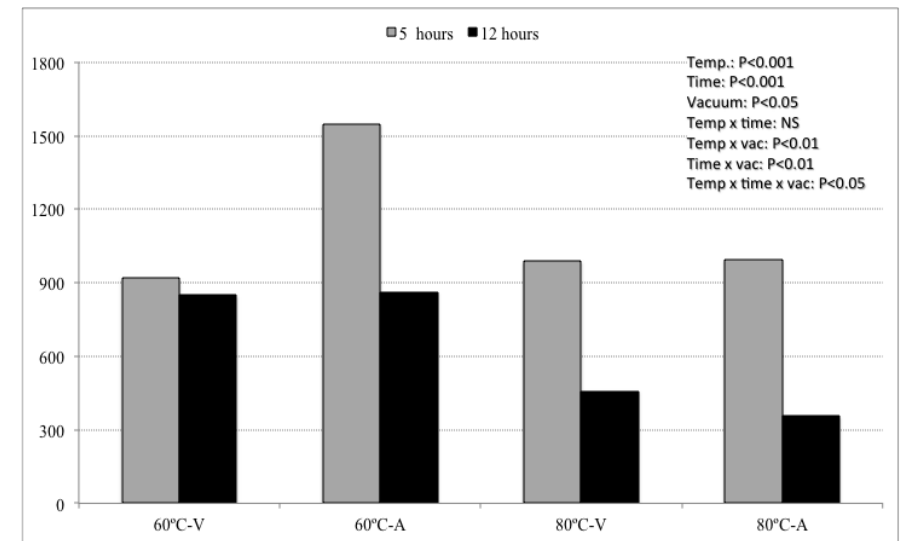
Figure 1. Hexanal/3-methyl butanal ratio in pork cheeks cooked at different combinations of temperature (60 vs. 80 °C), time (5 h vs. 12 h) and vacuum (vacuum packaged vs.